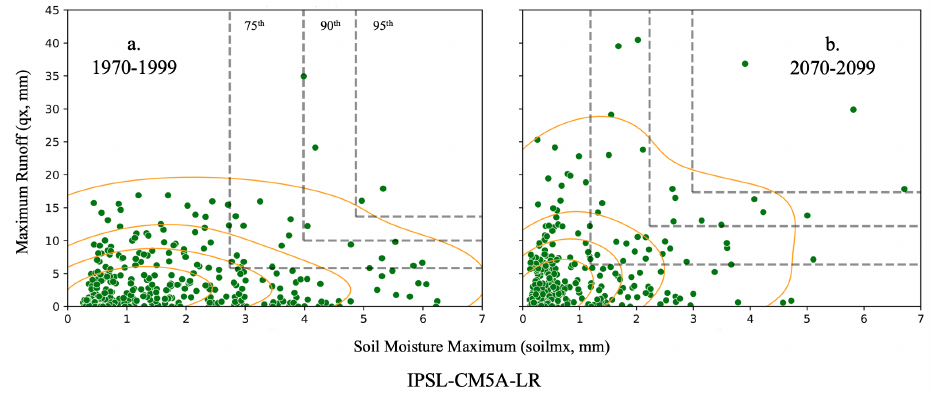
Figure 5. Historical ( a ) and future ( b ) copula for high precipitation (>1 of standard deviation) plotted as soil moisture maximum against maximum runoff for the Uncompaghre River basin. Darker colors indicate a higher density of data. Dashed lines show 95th, 90th, and 75th percentiles of the